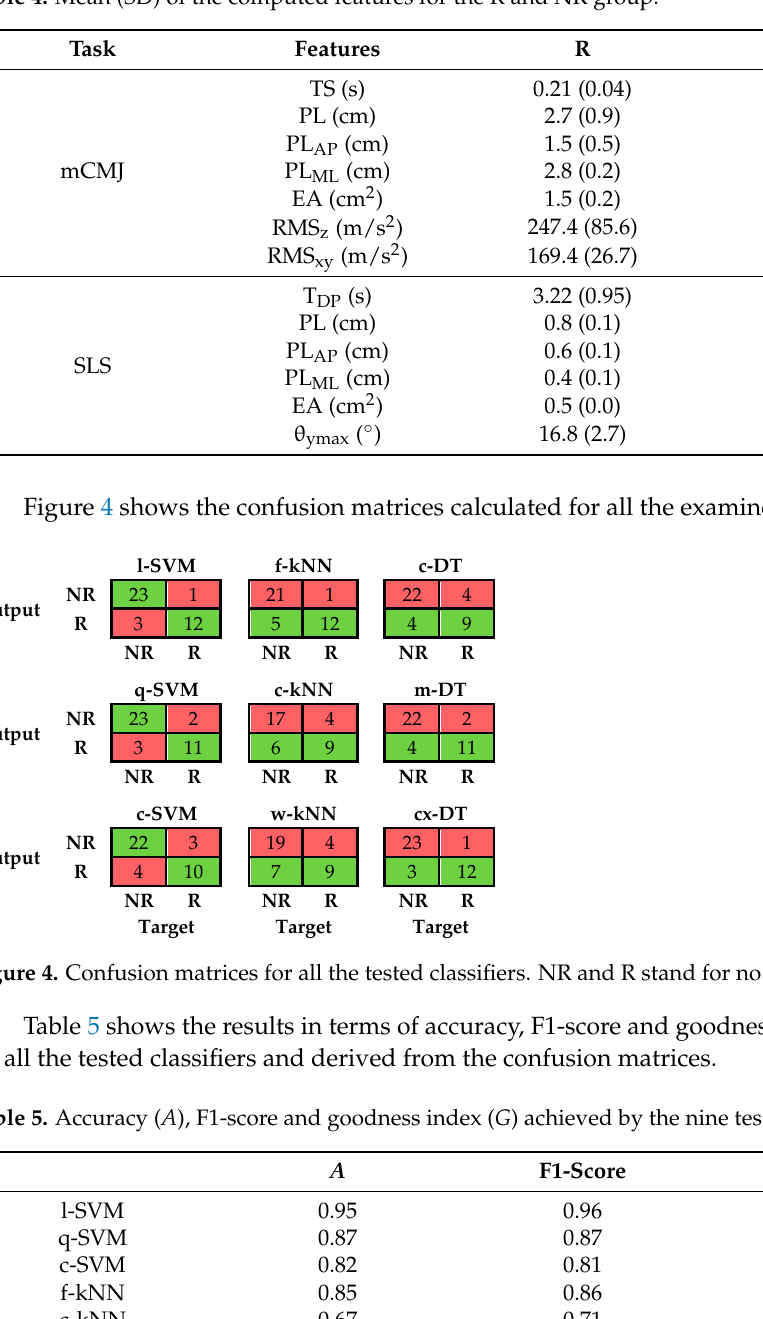
Table 4. Mean (SD) of the computed features for the R and NR group.